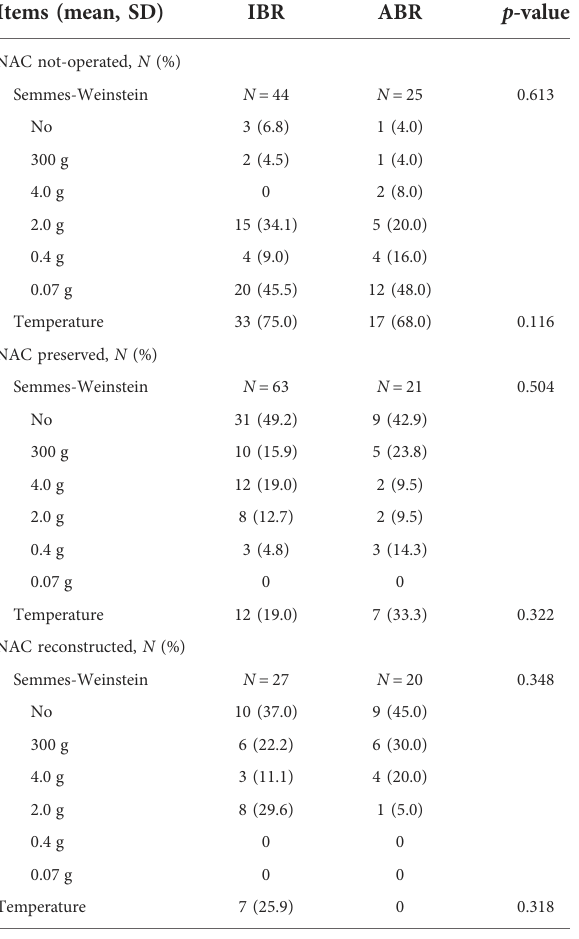
TABLE 4 Aesthetic outcome. TABLE 3 Evaluation of NAC